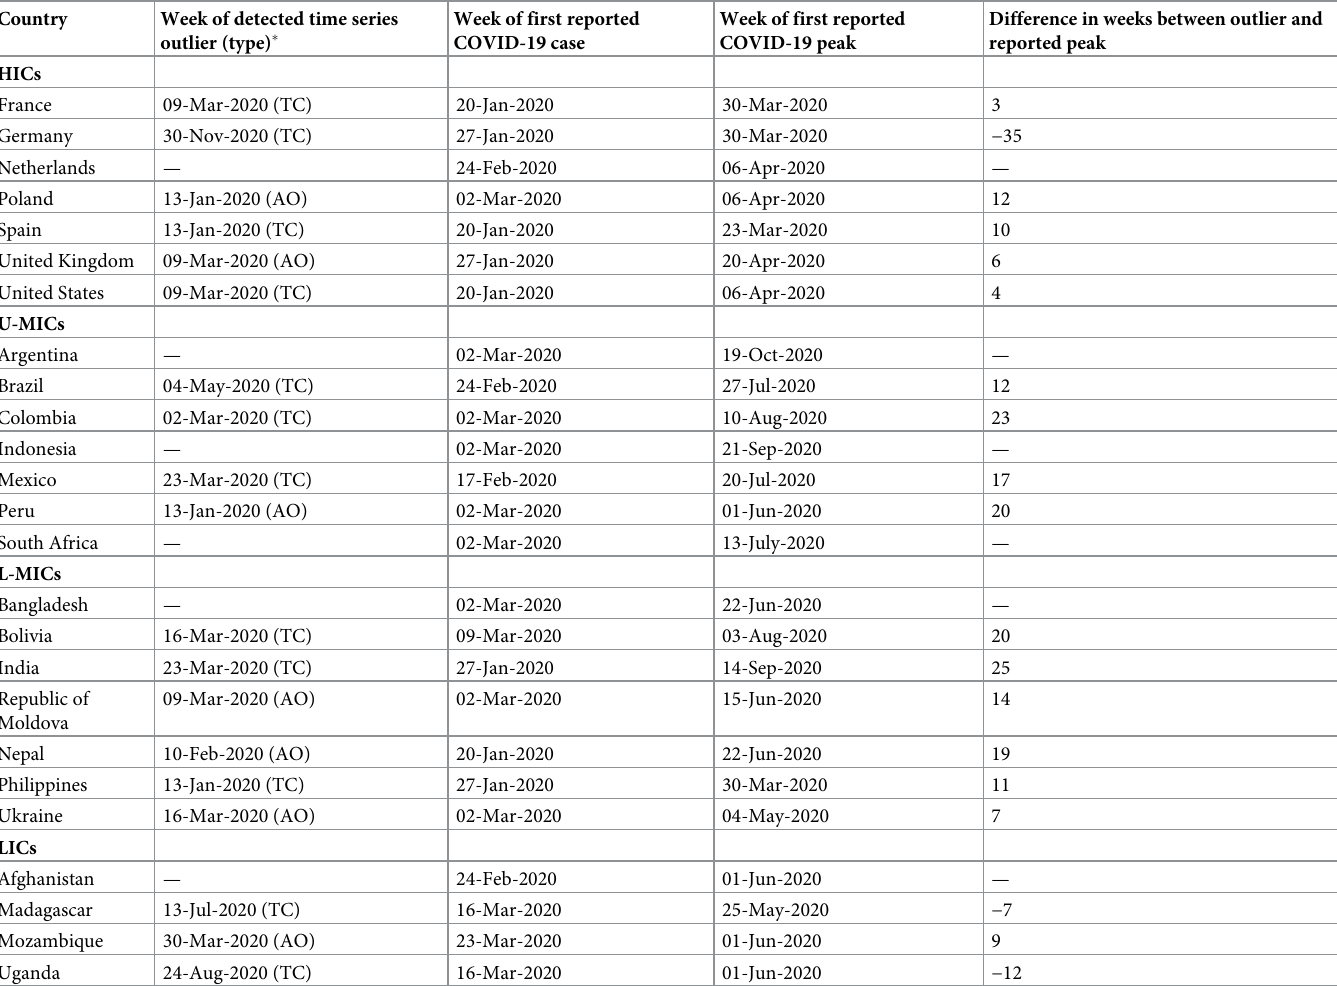
Table 2. Comparison by week of the first detected influenza-negative ILI time series outlier and the first reported COVID-19 case and peak by country.